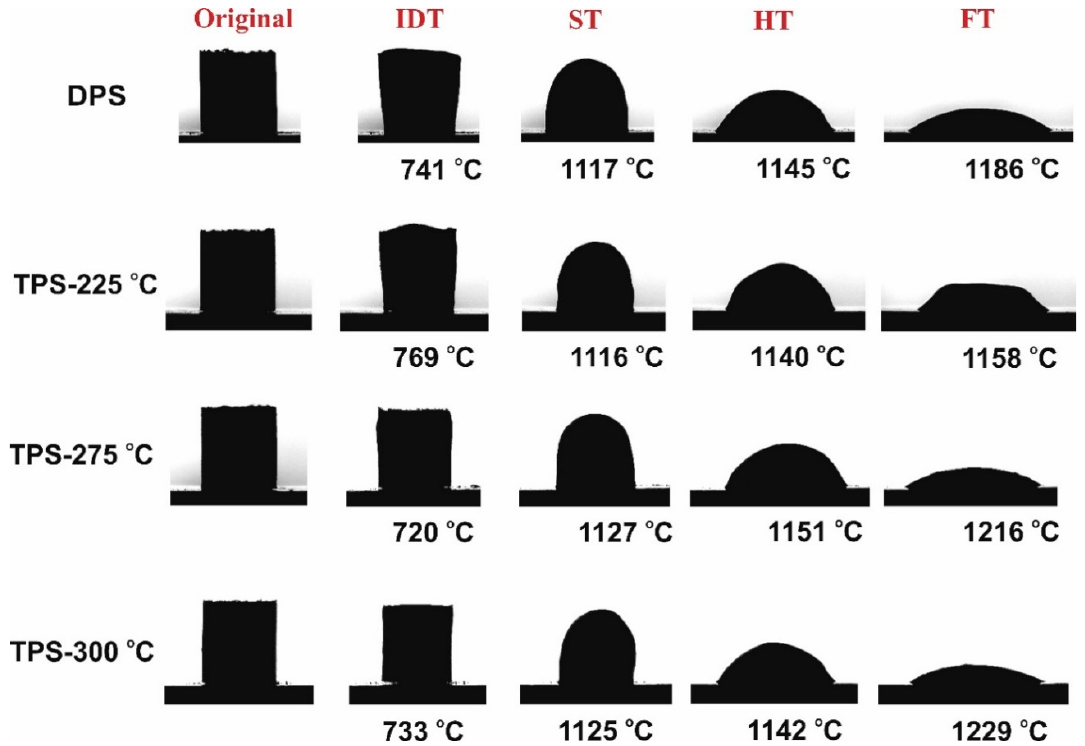
Figure 4. Ash melting temperatures of dried and torrefied pulp sludge. IDT = initial deformation temperature, ST = spherical temperature, HT = hemispherical temperature, FT = fluid temperature. Table 5. Ash fusion indexes of dried and torrefied pulp industry